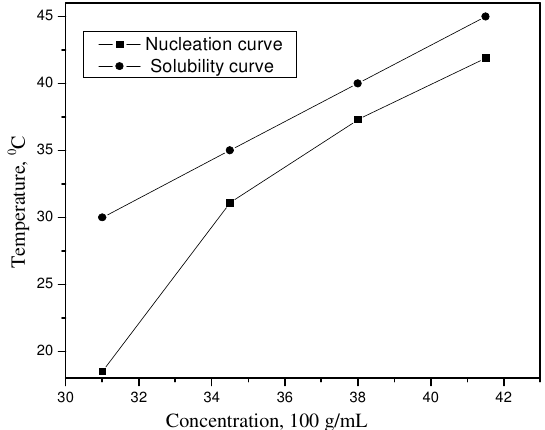
Figure 3 . Metastable zone width as a function of